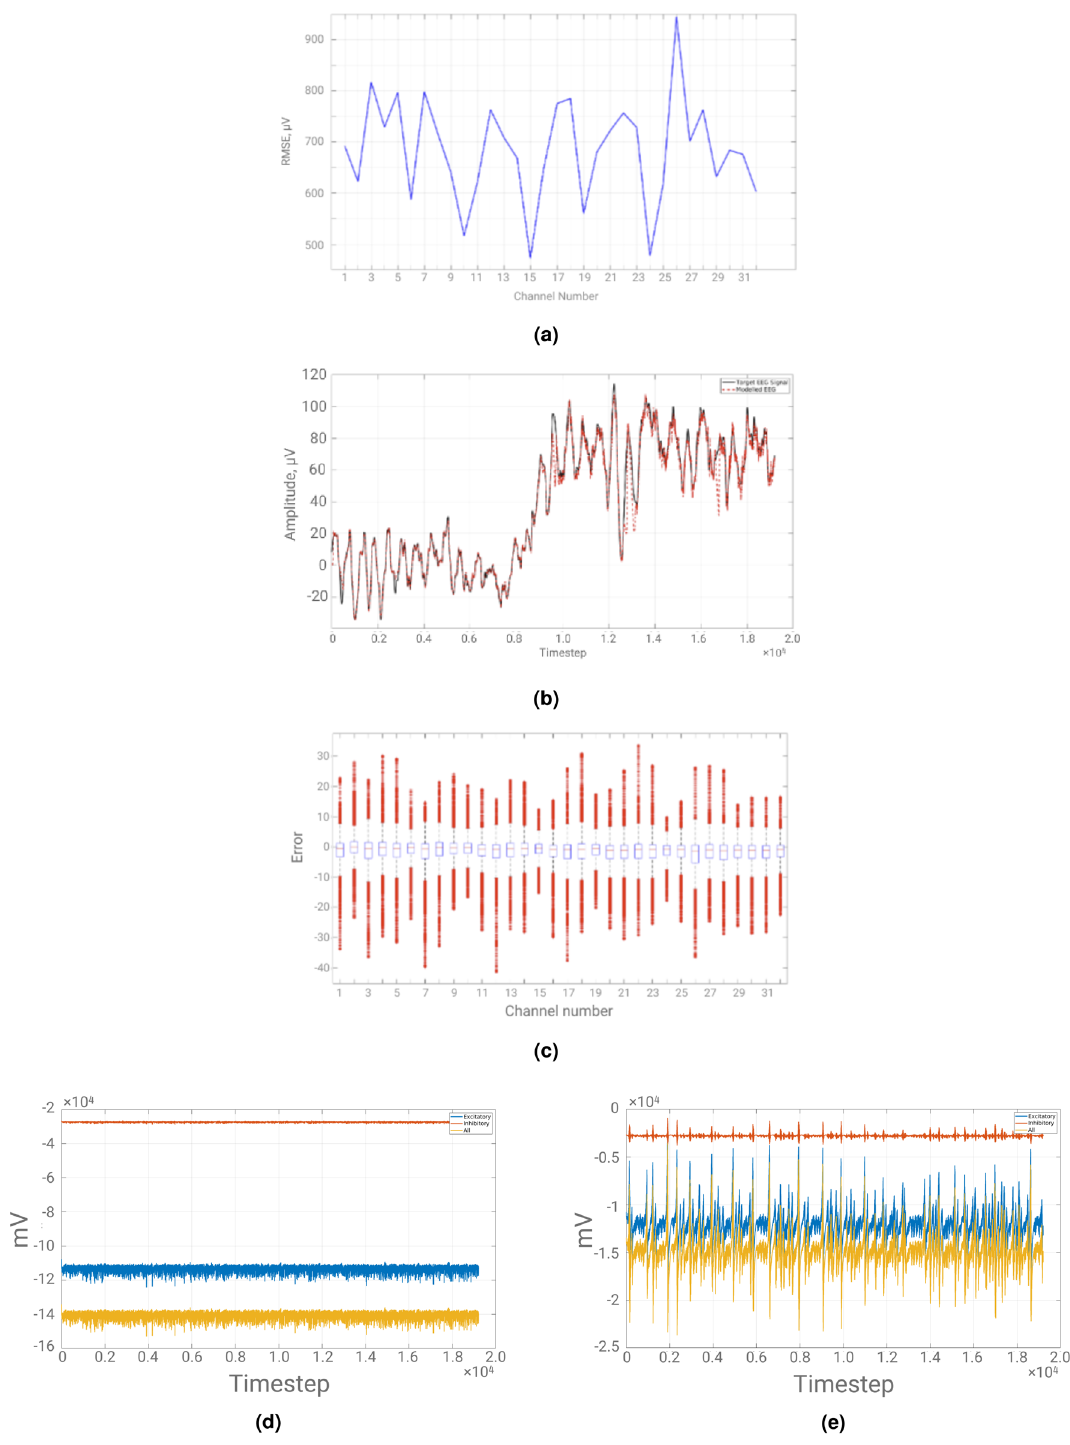
Figure 6. ( a ) Blue solid line shows the RMSE of undirected network for 32 EEG channels. ( b ) Undirected biologically-plausible RSNN with max. conductance delay of 20 ms-channel 26. Red dashed line shows “Modelled EEG signal”. Black solid line shows “Target EEG signal”. ( c ) Undirected network Boxplots of error for 32 EEG channels. Red crosses are data points beyond the whiskers. ( d ) Directed Network. Orange solid line shows voltage (mV) variation of inhibitory neurons. Blue solid line shows voltage (mV) variation of excitatory neurons. Yellow solid line shows voltage (mV) variation of the collective (i.e. sum) voltage (mV) of excitatory and inhibitory neurons. ( e ) Undirected Network. Orange solid line shows voltage (mV) variation of inhibitory neurons. Blue solid line shows voltage (mV) variation of excitatory neurons. Yellow solid line shows voltage (mV) variation of the collective (i.e. sum) voltage (mV) of excitatory and inhibitory